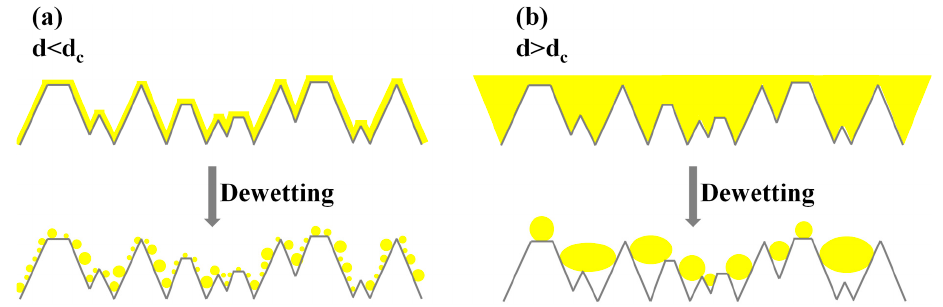
Figure 12. Pictures of the result of the AuPd dewetting process on the untreated FTO: ( a ) nanoparticle formation from the dewetting process of the Au film having a thickness d lower than a critical value d c ; and ( b ) nanoparticle formation from the dewetting process of the Au film having a thickness d higher than a critical value d c .